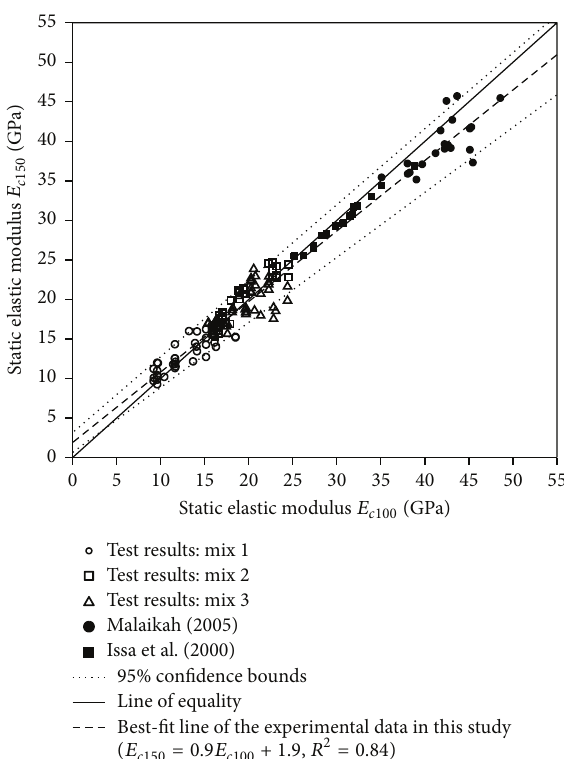
Figure 4: Comparison of static elastic moduli of concrete measured from 100 by 200 mm and 150 by 300 mm cylinders ( 𝐸 𝑐100 and 𝐸 𝑐150 , resp.).